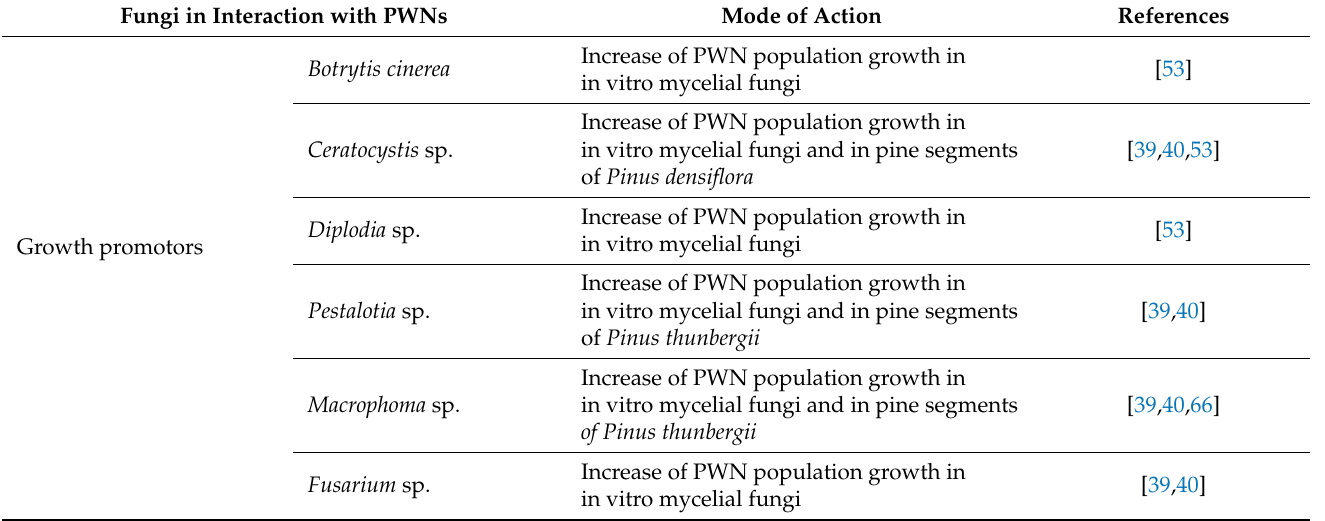
Table 2. Nematode-fungi interactions in pine wilt disease (PWD). List of fungal species with a positive effect on pine wood nematode (PWN) multiplication and distribution, and potential agents for biocontrol applications with respect to PWD